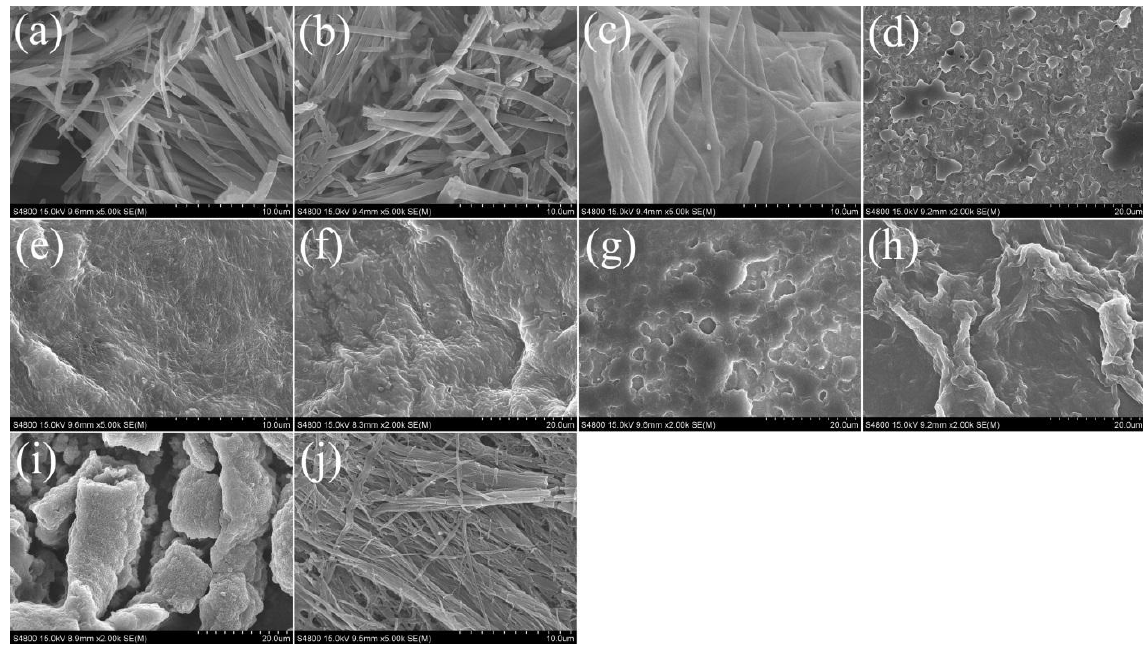
Figure 2. SEM images of xerogels from CH-PY gels: ( a – j ) n-butanol, n-pentanol, isopentanol, isooctanol, cyclopentanone, cyclohexanone, nitrobenzene, n-butyl acrylate, THF, DMF,